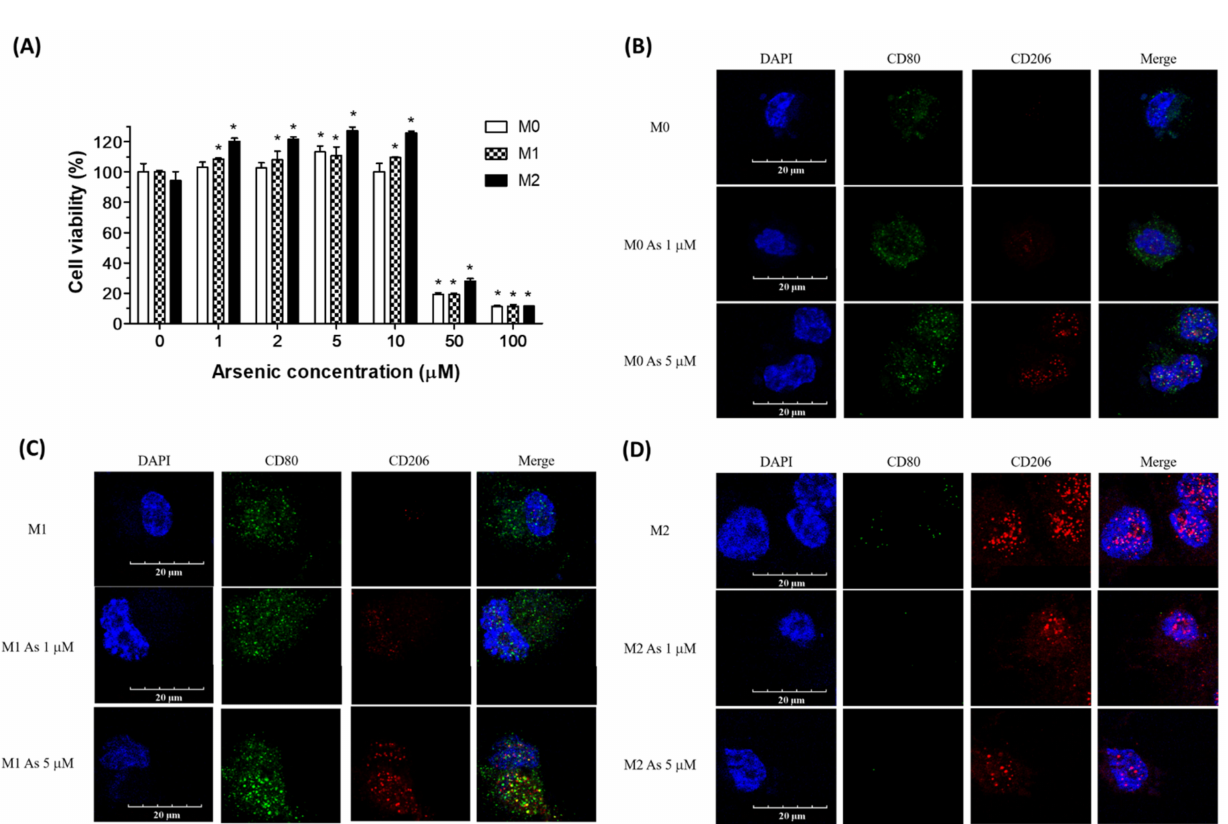
Figure 1. Non-toxic concentrations of arsenic increase CD206 + M2 macrophages. ( A ) THP-1 derived M0, M1, M2 macrophages were treated with 1–100 µ M of arsenic for 24 h, and cell viability (% of M0 control) was analyzed by the XTT assay. * p < 0.05, arsenic-treated vs. untreated M0 cells, arsenic-treated vs. untreated M1 cells, or arsenic-treated vs. untreated M2 cells, by the Kruskal–Wallis test, (N = 3). ( B – D ) THP-1-derived M0, M1, M2 macrophages were treated with 1 or 5 µ M arsenic for 24 h. The treated cells were stained for CD80 (M1 surface marker, green fluorescence), CD206 (M2 surface marker, red fluorescence), and DAPI (DNA counterstain, blue fluorescence). The cell images were observed under a fluorescence microscope (200 × ) (N =